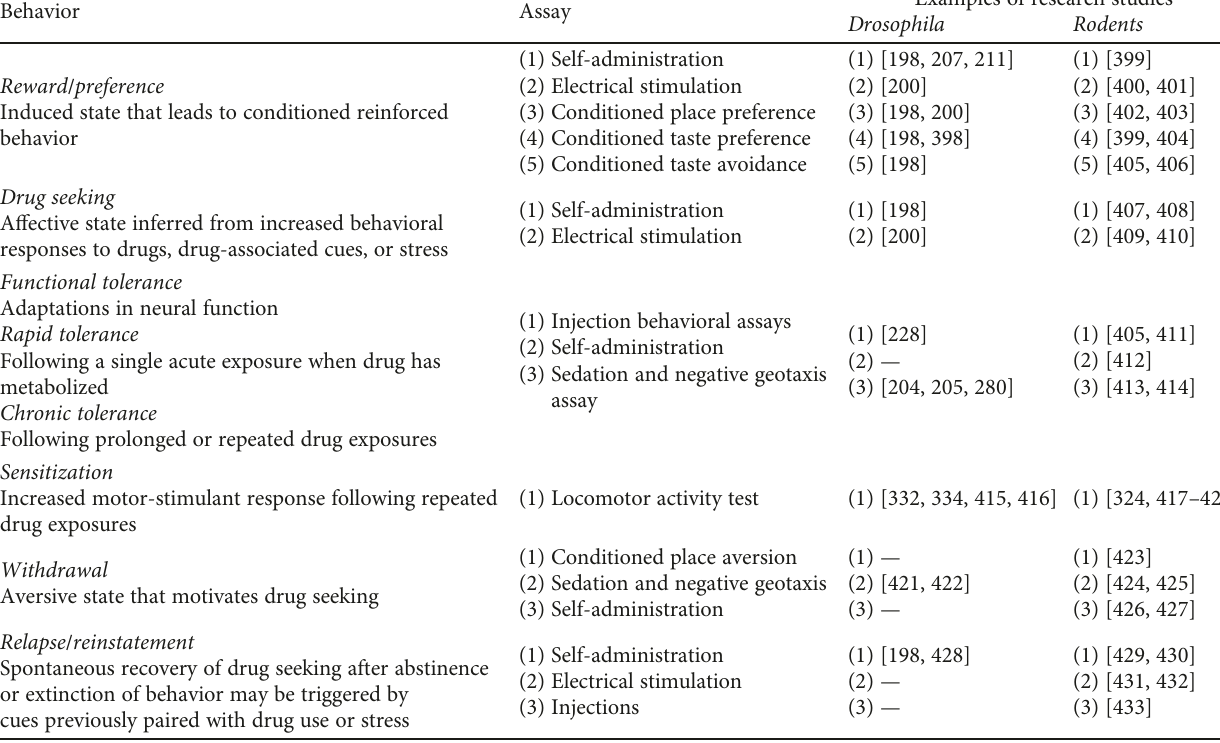
Table 1: Behavioral measures and assays of drug addiction in Drosophila and